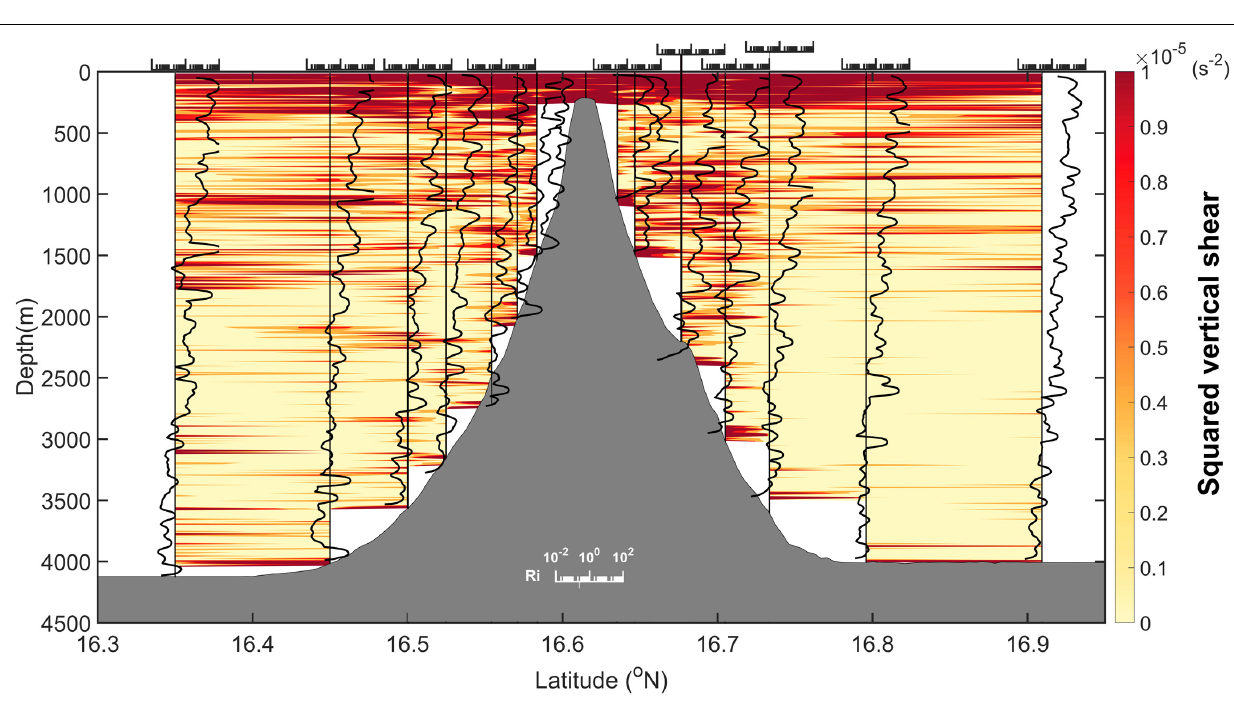
FIGURE 4 | Spatial distributions of the squared vertical shear S 2 = u 2 z + v 2 z (colors) and Richardson number R i = N 2 / S 2 (black profiles) acquired from CTD and LADCP profiling along the meridional section of the seamount. The scale for R i is given at the lower center and redrawn above each profile with a vertical line indicating R i =